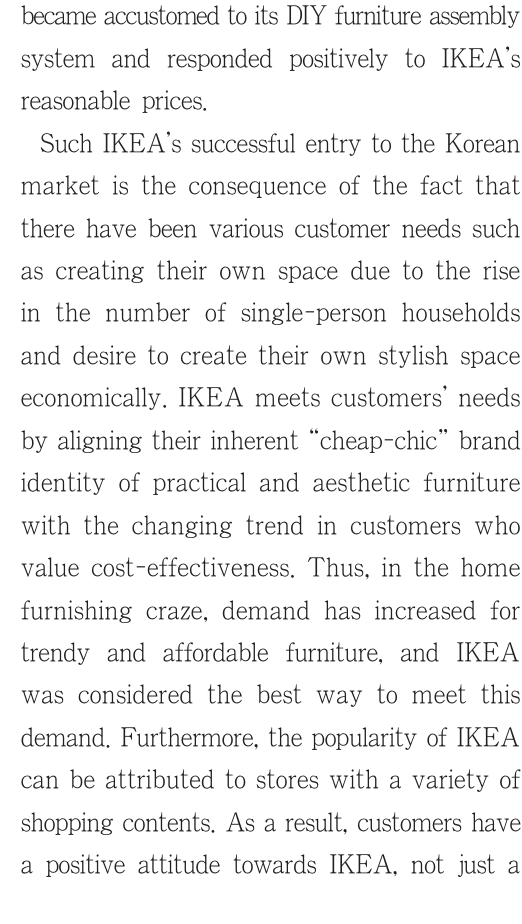
<Table 1> Key Business Area of Major